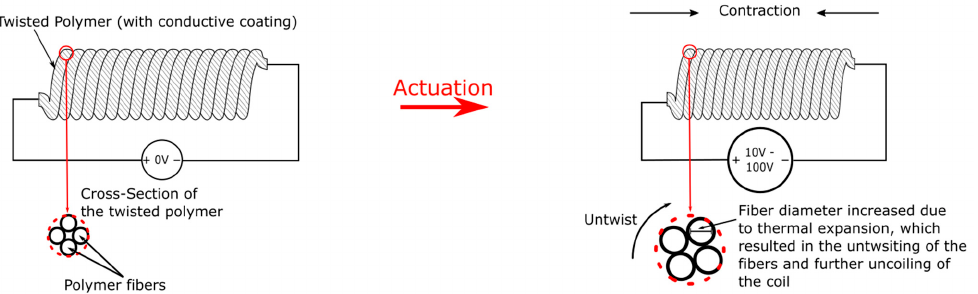
Figure 6. The actuation scheme of a contracting twisted and coiled polymer. The conductive coating of the twisted fibers allows for Joule-heated actuation, and usually around 10–20 V/cm actuation voltage is required for significant contraction, but this is strongly dependent on the chosen polymer and coating material (i.e., resistivity, heat conductivity, etc.). Heating will cause the fiber diameter to increase, which induces an untwisting motion of the fiber, and this will ultimately cause the uncoiling of the coil, creating a contracting motion. Early versions of conductive twisted coil polymers were demonstrated by Lima et al. in 2012 [69]. The group made TCPs out of carbon nanotube yarns, and those actuators had been shown to lift loads 17,700 times their own weight over 3% strain under 18.3 V/cm and 20 Hz applied voltage. Despite the attractive actuation performance, CNT yarns are expensive for prototyping and production. To reduce the cost problem, Haines et al. pro- posed the use of nylon 6,6 and nylon 6 fishing lines to manufacture a cheaper (~$5/kg) and more powerful actuator [70]. The group proposed two coiling techniques: super-coiling (self-coiling) by continuous twisting and wrapping the fibers around a mandrel. Both techniques require annealing to stabilize the fibers into the coiled configuration. By heat- ing super-coiled nylon 6,6 actuators from 20 °C to 120 °C, maximum strains of 21% at loading stress of 22 MPa and 9.3% at 50 MPa were achieved. Meanwhile, mandrel-coiled nylon 6 showed larger strain but less capability for loading stress. A maximum contraction of 49% contraction under 1 MPa loading stress was shown. Maximum specific energy of 2.48 kJ/kg and average specific power of 27.1 kW/kg during contraction were reported in general. Nevertheless, efficiency was around 1%, and specific power over a full activation cycle would be much lower than that during actuation due to extensive cooling time. The group showed that a self-coiled nylon 6,6 actuator could endure 1 million actuation cycles. Each cycle was powered by a voltage of 30 V/cm at 1 Hz that caused the actuator to lift 10 g (22 MPa) load at 20% duty cycle. Scaling up force output could be achieved by weaving and braiding, as shown by Simeonov et al. [71]. The study focused on comparing 2D weaving, 2D braiding, and 3D braiding. Results showed that both weaving and braiding were good force amplification measures. 3D braiding was the best for force amplification and energy efficiency but had a lower bandwidth relative to 2D braiding. Braiding outperformed weaving in force am- plification, bandwidth, and energy efficiency overall, but weaving may be essential for applications where flat actuators are desired over bundled ones. Self-sensing can be made by relating string length with string resistance as Bombara et al. showed that as the string elongated, resistance also increased as a result of a larger distance between adjacent coils [72]. Performance optimization through different plying patterns was studied by Cho et